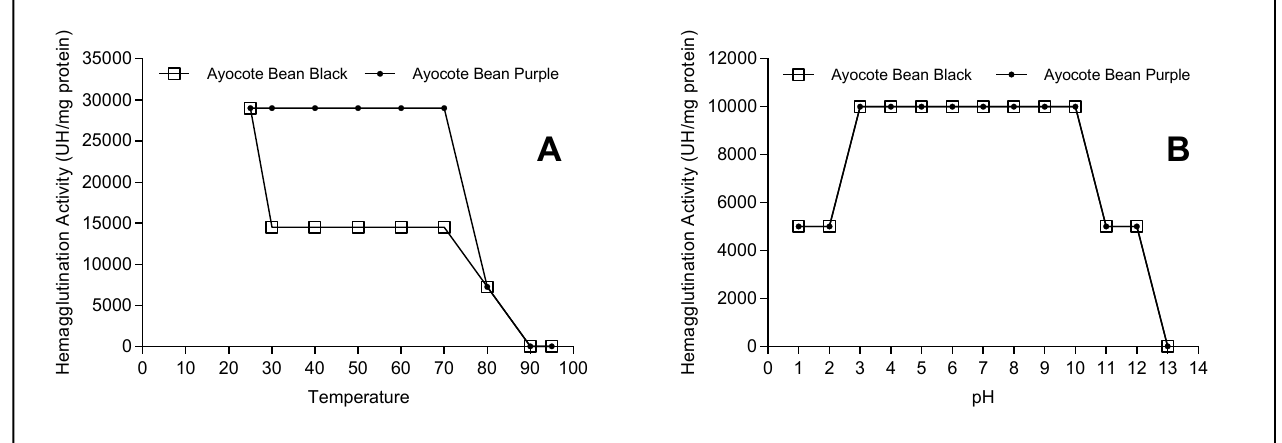
Figure 3. Modification of the hemagglutinating activity of the lectins of two varieties of Phaseolus coccineus by the effect of ( A ) temperature and ( B ) pH.